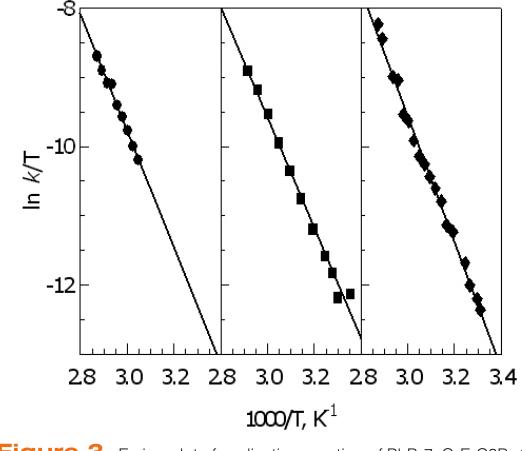
Figure 3. Eyring plot of cyclization reaction of PhBr7. C-E-C2Br (  ), C-P-C2Br (  ), C-B-C2Br (  ).